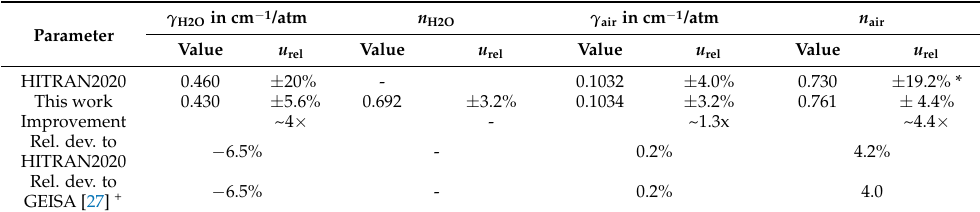
Table 1. Self- and air broadening coefficients and respective temperature dependence coefficients for the H 2 O absorption line at 7299.43 cm − 1 . For this comparison table, all uncertainties ( u rel ) are expanded ( k = 2), with k = 2 producing an interval with a level of confidence of 95% that the true value is included